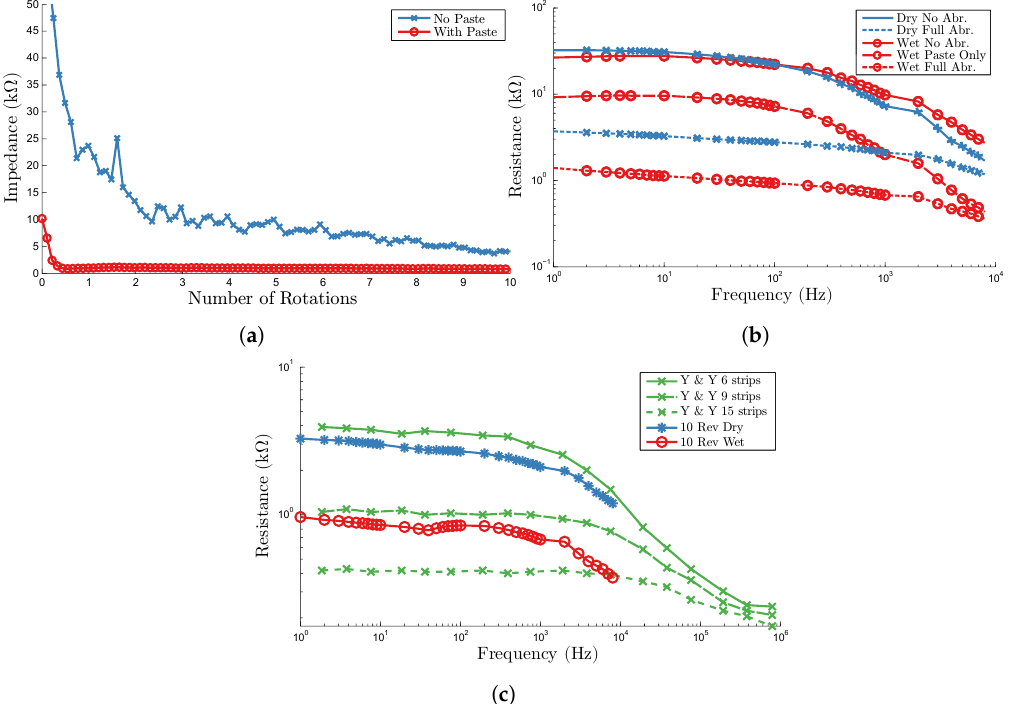
Figure 7. Human forearm results ( a ) impedance decrease during electrode rotation, with and without abrasive conductive paste ( b ) impedance spectra before (solid) and after (dashed) abrasion with and without paste and with the addition of paste only (dotted) ( c ) comparison of corrected resistance spectra after wet and dry abrasion with the spectra after 9 and 15 strips from Yamamoto and Yamamoto [41]